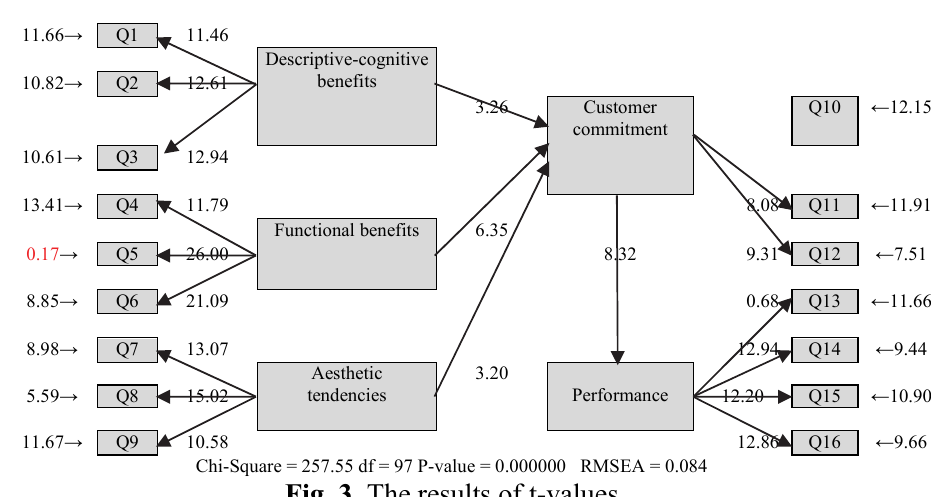
Fig. 2. The results of standard coefficients